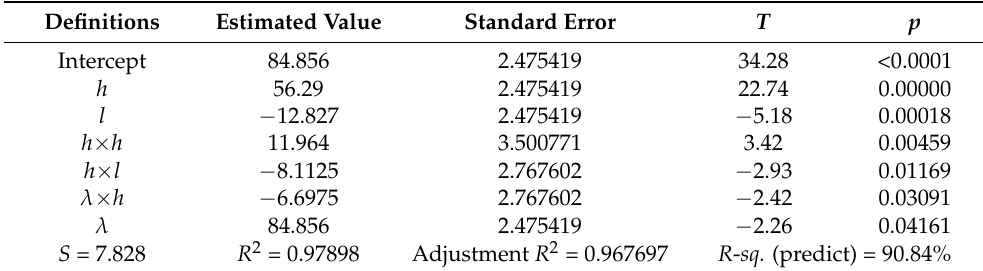
Table 8. Parameter estimates and ANOVA table for the reduced